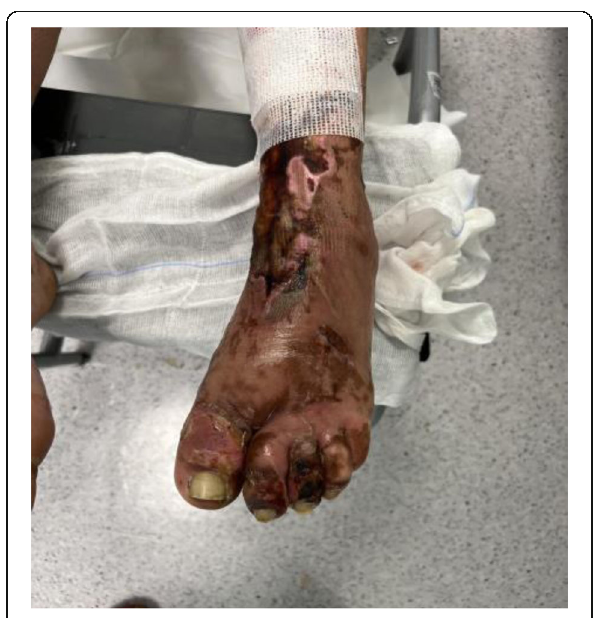
Fig. 3 (abstract A98). See text for